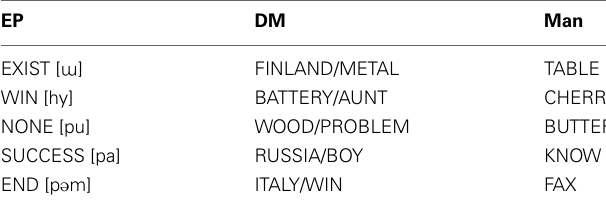
Table 5 | Examples of stimuli in fMRI study (EP syllables in